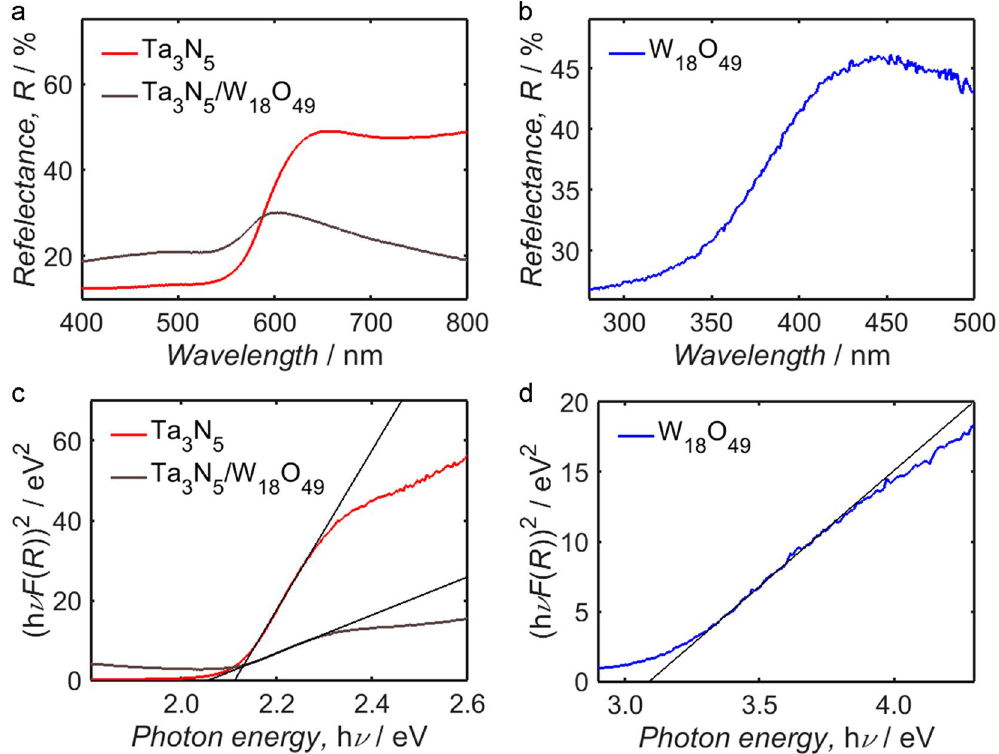
Figure 6. Diffuse reflectance spectra of Ta 3 N 5 and Ta 3 N 5 /W 18 O 49 ( a ), as well as W 18 O 49 ( b ), with corresponding Tauc plots in ( c , d ), respectively. By plotting a line-of-best-fit through the point of maximum gradient within each Tauc plot, an estimate of the optical band gap may be obtained; values of ca. 2.1 eV are estimated for both Ta